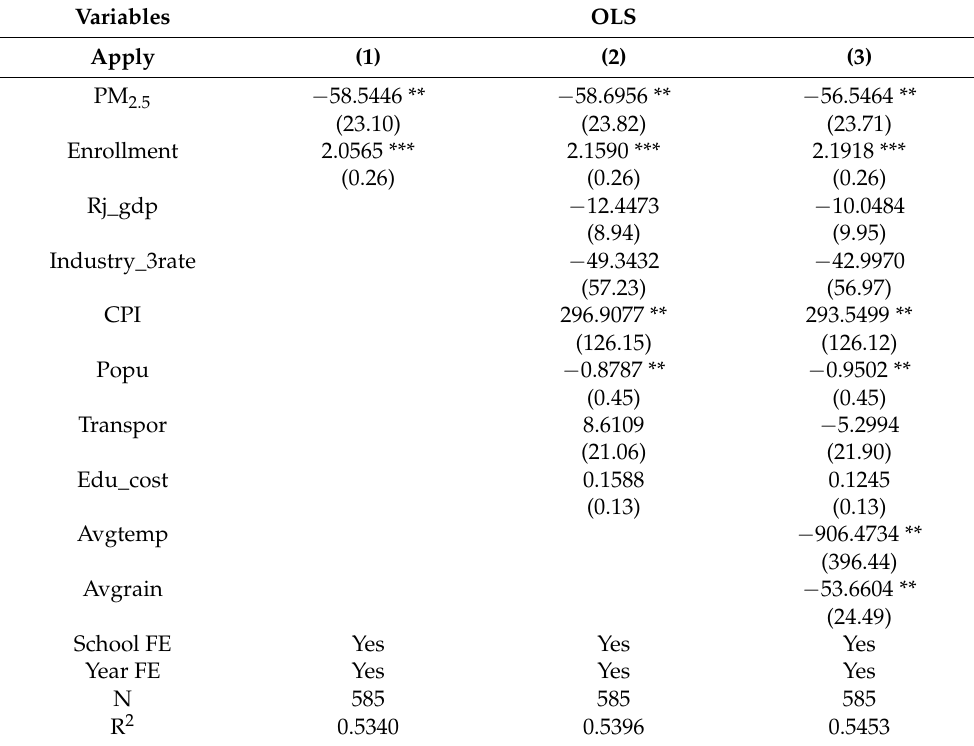
Table 2. Impact of air pollution on applicants’ number (OLS